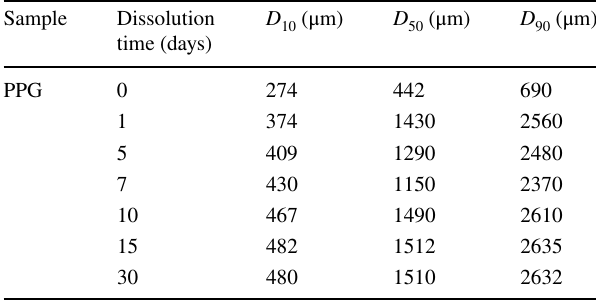
Table 2 PPG particle size and its cubic expanding results at 57 °C